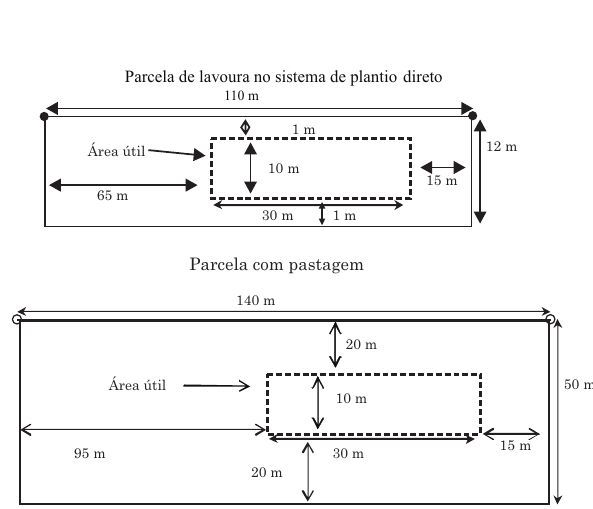
Figura 2. Esquema utilizado para avaliação da infiltração estável e da infiltração de água no solo nos tratamentos de lavoura contínua, pastagem contínua e integração lavoura-